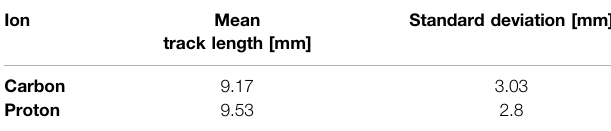
TABLE 4 | Mean track length values and standard deviations of protons and carbon ions traversing a spherical TEPC of 12.6 mm diameter. The mean chord length of this detector exposed to a uniform and isotropic radiation fi eld is 8.47